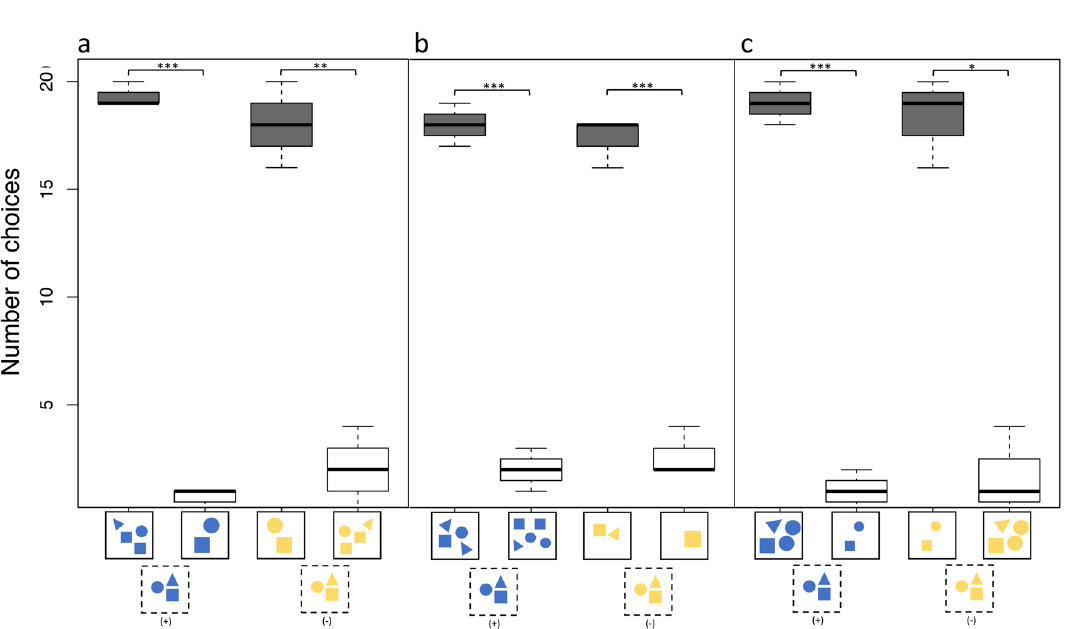
Figure 7. Overview of stingray (n = 3) choices in all three transfer tests. ( a ) Transfer test type A; ( b ) Transfer test type B; ( c ) Transfer test type C. Schematic examples on which the individuals based their choice are presented on the x-axis. Stimuli in the dashed box show the test stimulus presented first, and solid boxes contain the choice stimuli that followed. Dark bars represent correct choices, transparent bars incorrect ones. p < 0.01*, p < 0.001**, p <